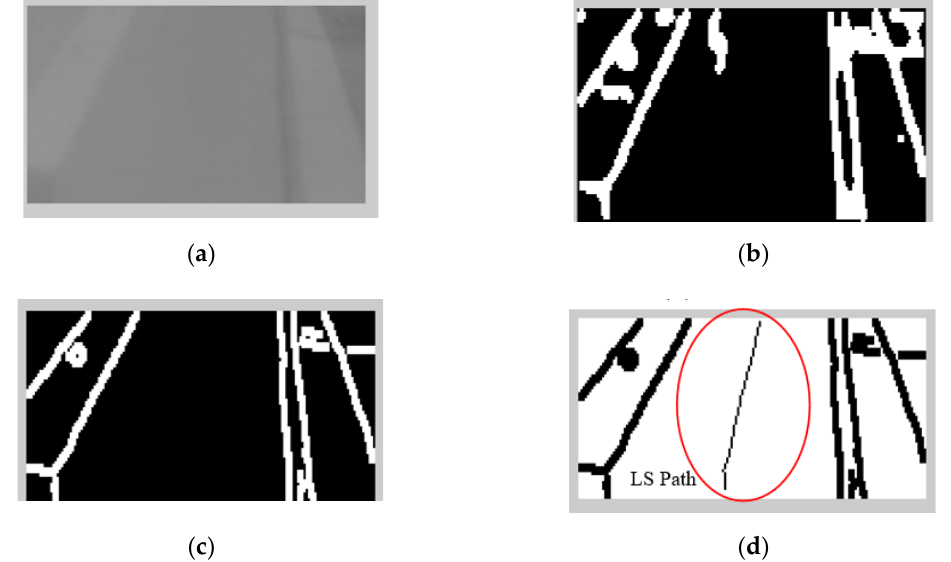
Figure 4. Image sequences processing where no roundabout can be detected using LS: ( a ) original image gray scale, ( b ) image after applying curbs detection, ( c ) image after removing the noise, and ( d ) image after applying the LS (continuous line in the middle).